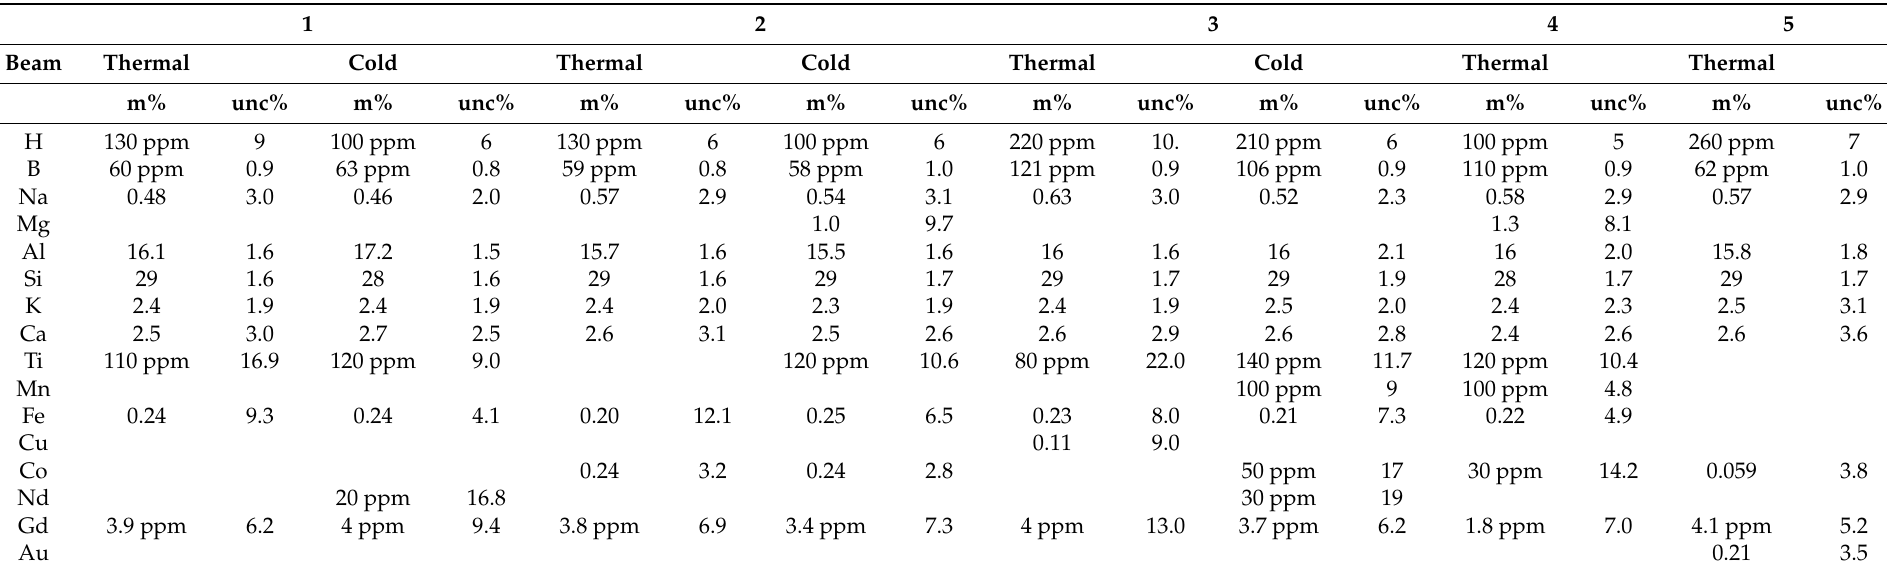
Table 1. Concentrations (m%) by PGAA at measurement spots shown in Figure 3a, together with their 1-sigma relative uncertainties. 1 2 3 4